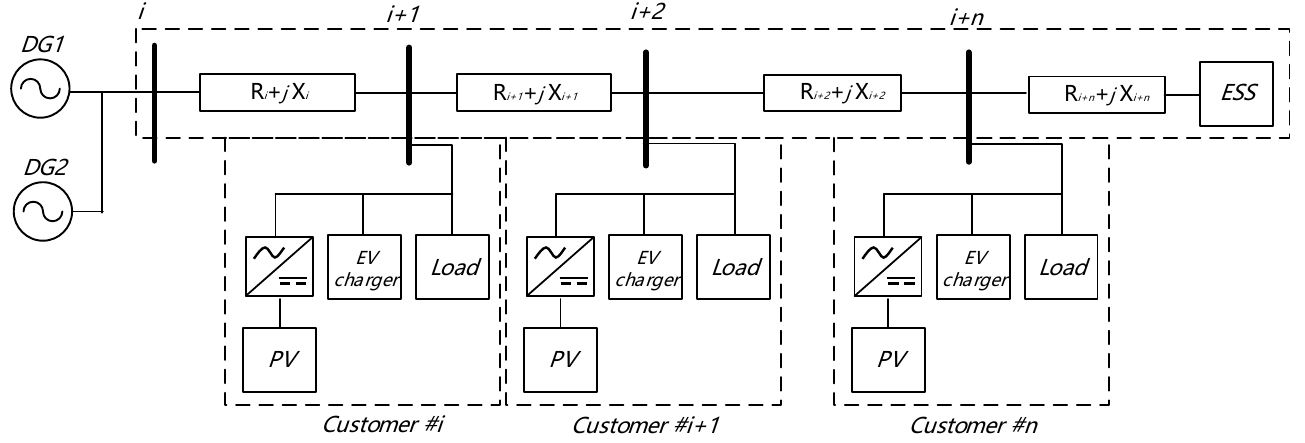
Figure 1. A stand-alone MG with multiple buses.